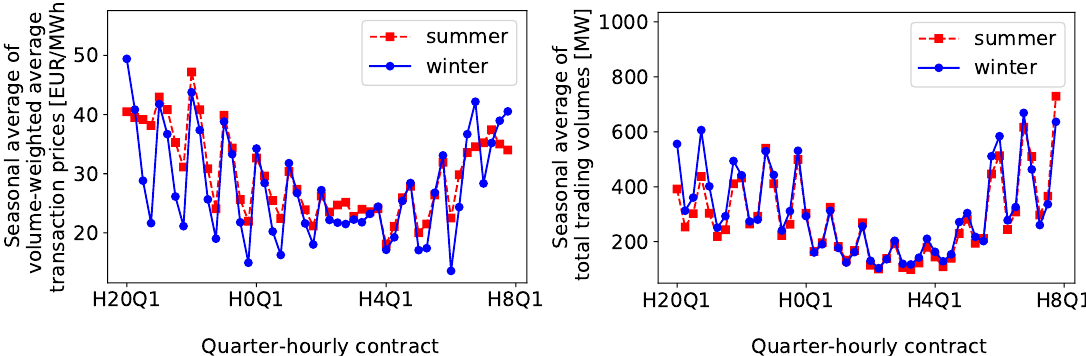
Figure 1. Volume-weighted average transaction price ( left ) and total trading volume ( right ) of 15-min. contracts during off-peak hours averaged over summer (red) and winter